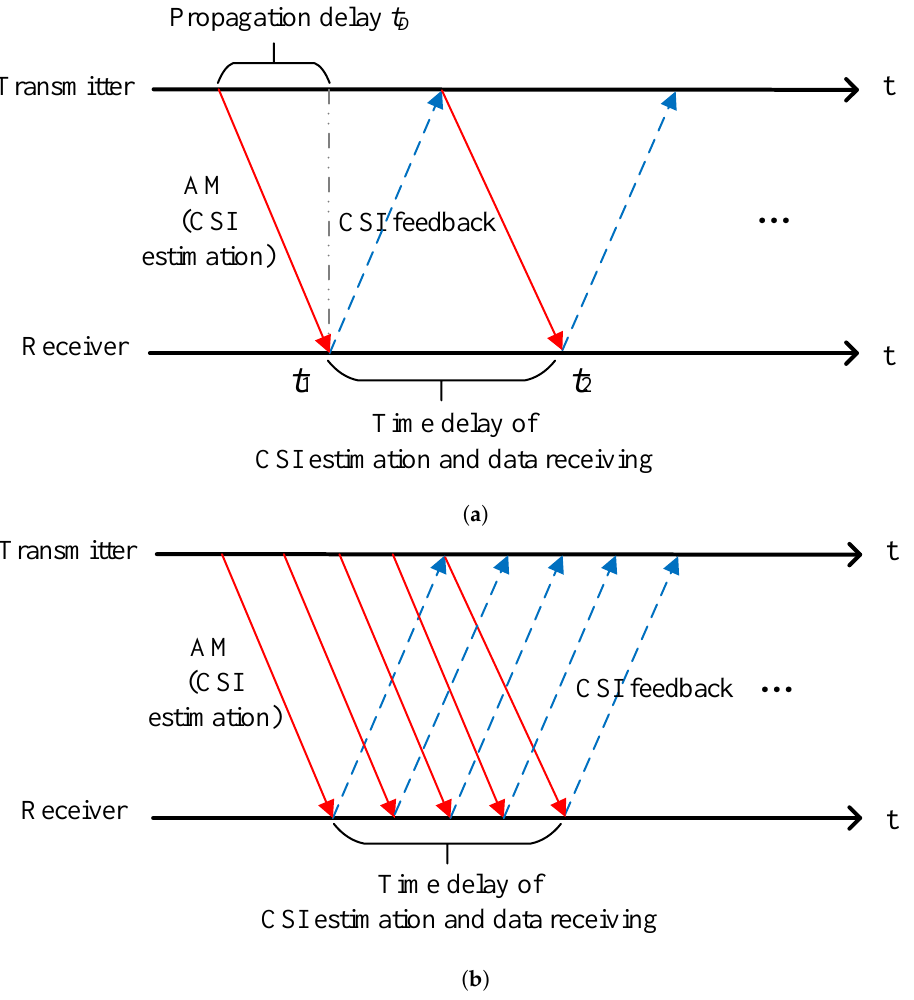
Figure 2. The propagation delays in the UWA adaptive modulation process: ( a ) the propagation delays in classical UWA AM [12,27]; ( b ) the propagation delays in UWA AM with continuous transmissions